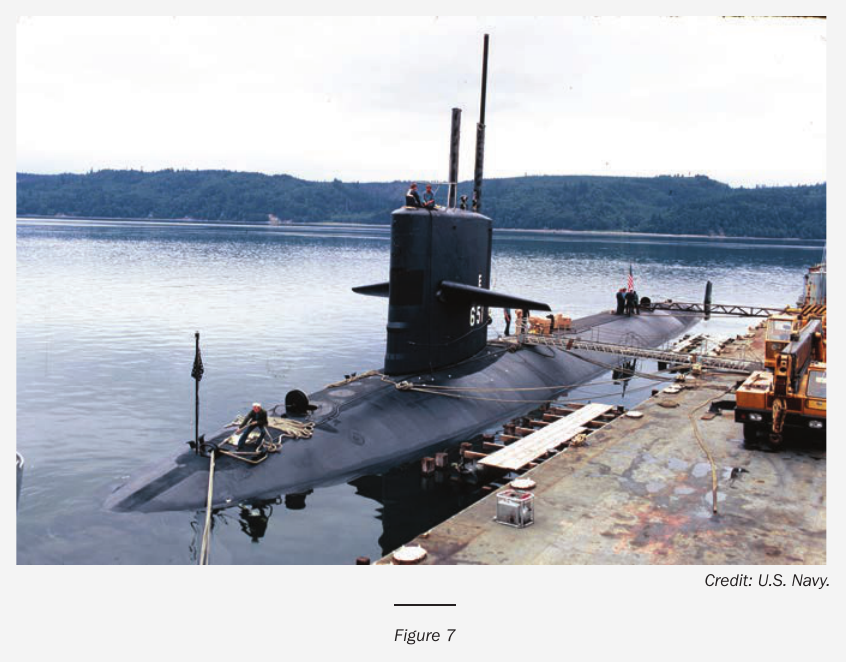
shows Queenfi sh’s control room and the watch standers that were responsible for navi- gating the submarine. We departed Seattle, Washing- ton, enroute to the Bering Strait, which we planned to Credit: U.S. Navy. pass through and beyond into the Chukchi Sea on the 30 th of July 1970.